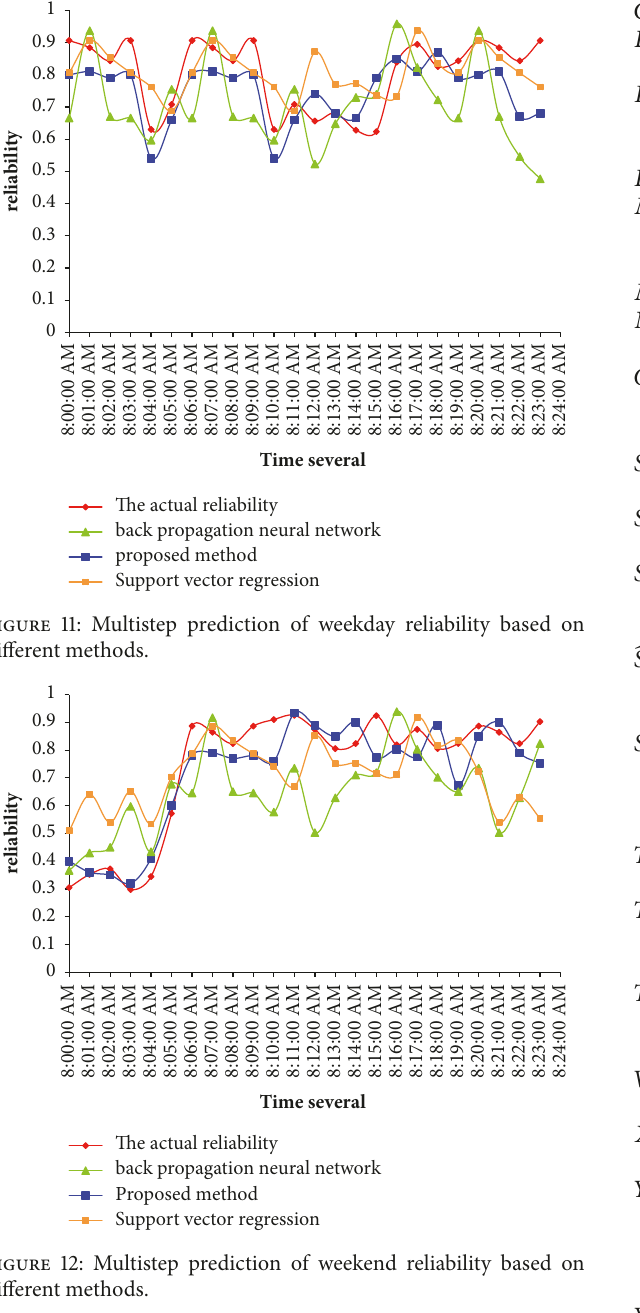
Figure 12: Multistep prediction of weekend reliability based on different